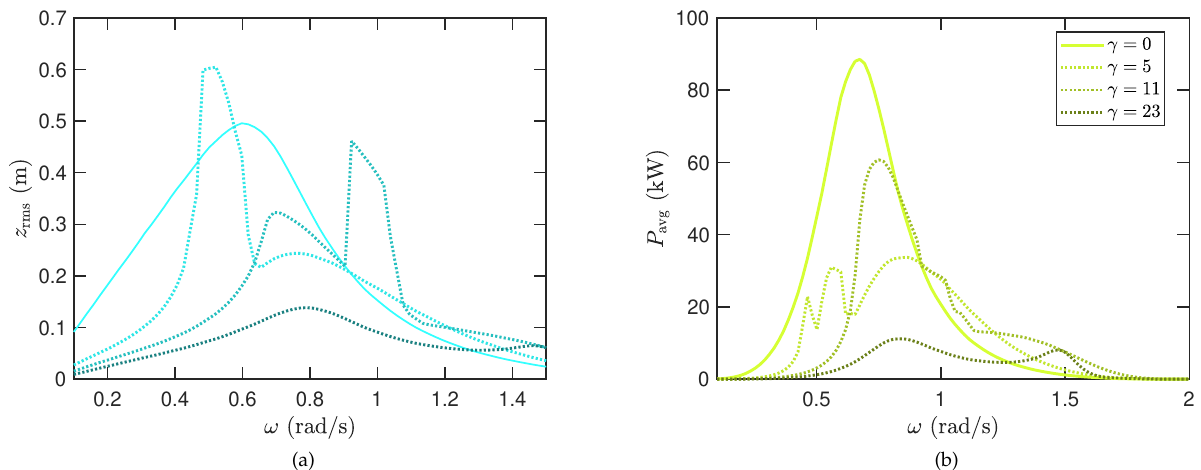
Fig. 8. The resulting peak motion (8a) and the time-averaged power (8b) for the 1-DOF scenario and varying γ , using PTO settings found from (8) at ω = 0 . 77 rad / s .